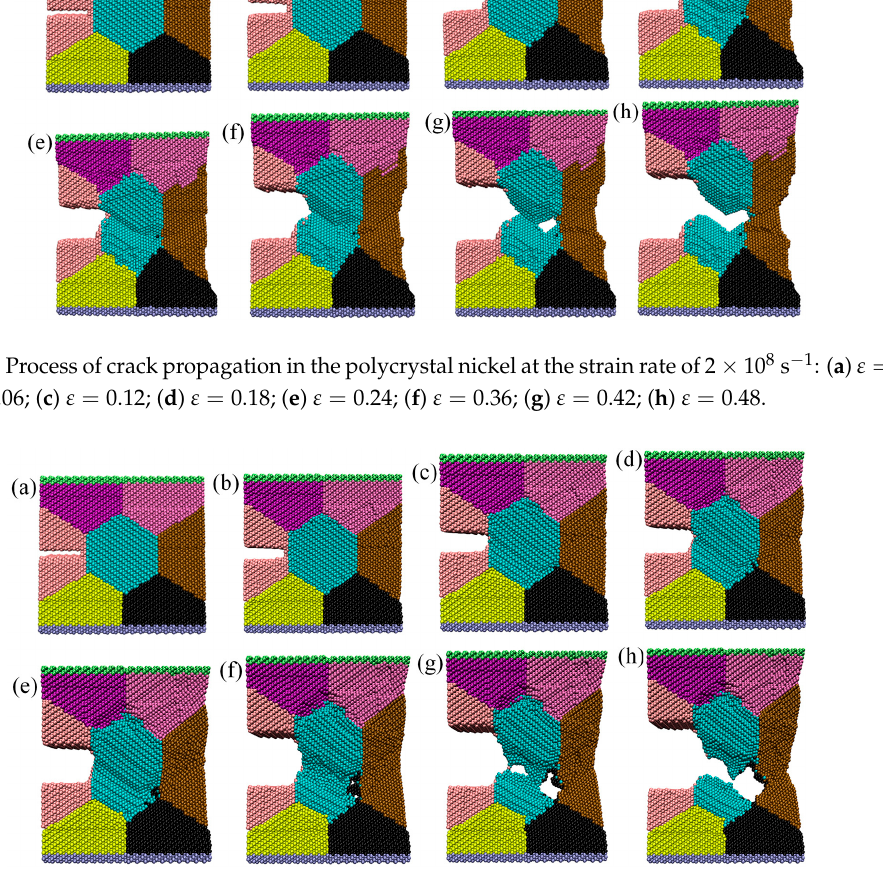
Figure 3. Process of crack propagation in the polycrystal nickel at the strain rate of 2 × 10 10 s − 1 : ( a ) ε = 0; ( b ) ε = 0.06; ( c ) ε = 0.12; ( d ) ε = 0.18; ( e ) ε = 0.24; ( f ) ε = 0.36; ( g ) ε = 0.42; ( h ) ε = 0.48.